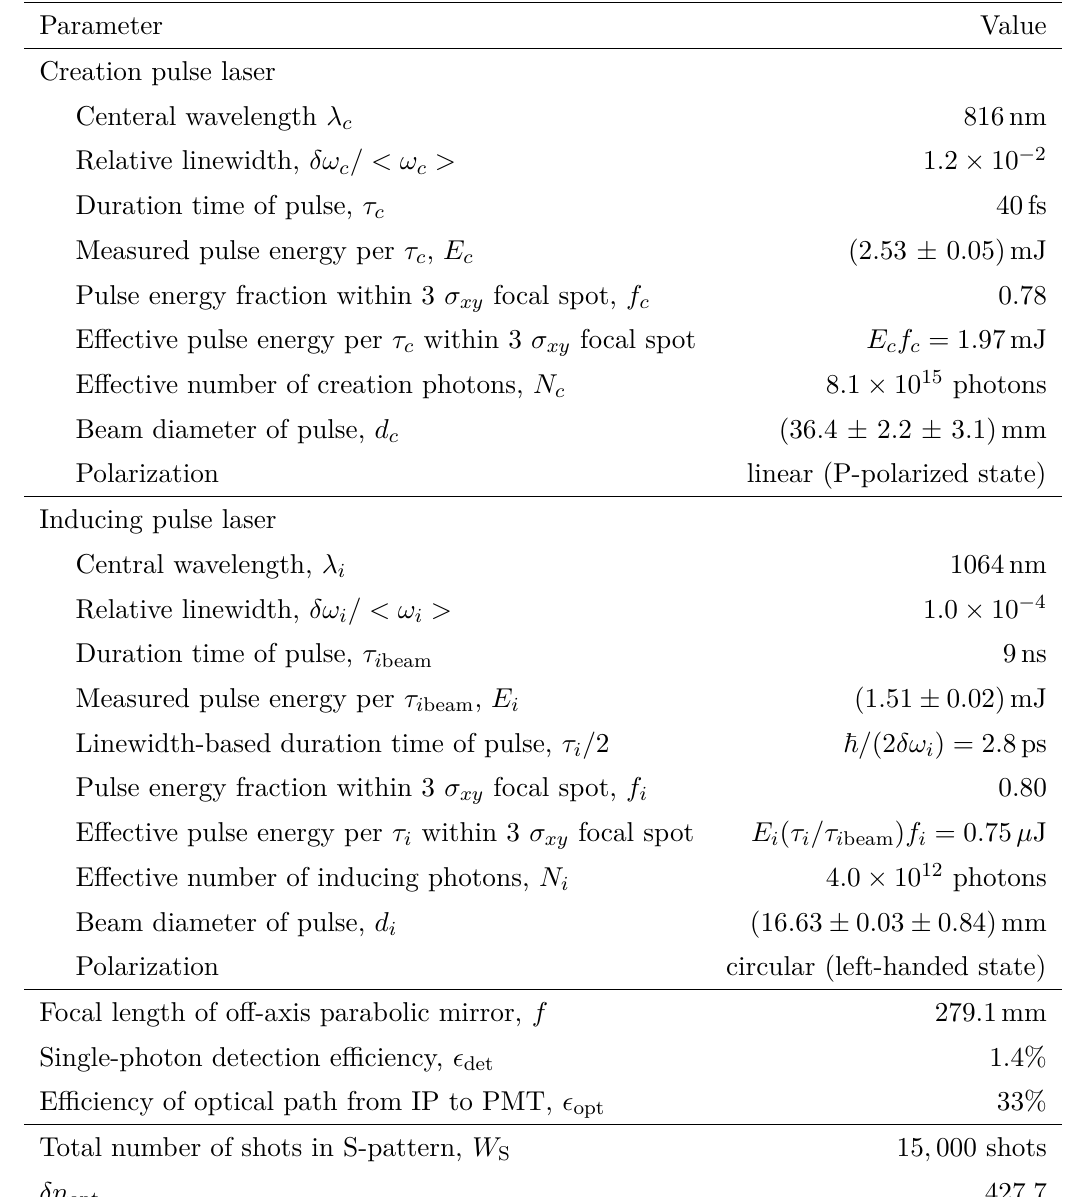
Table 2 . Experimental parameters for numerical calculation of the exclusion limits in the m − g/M parameter